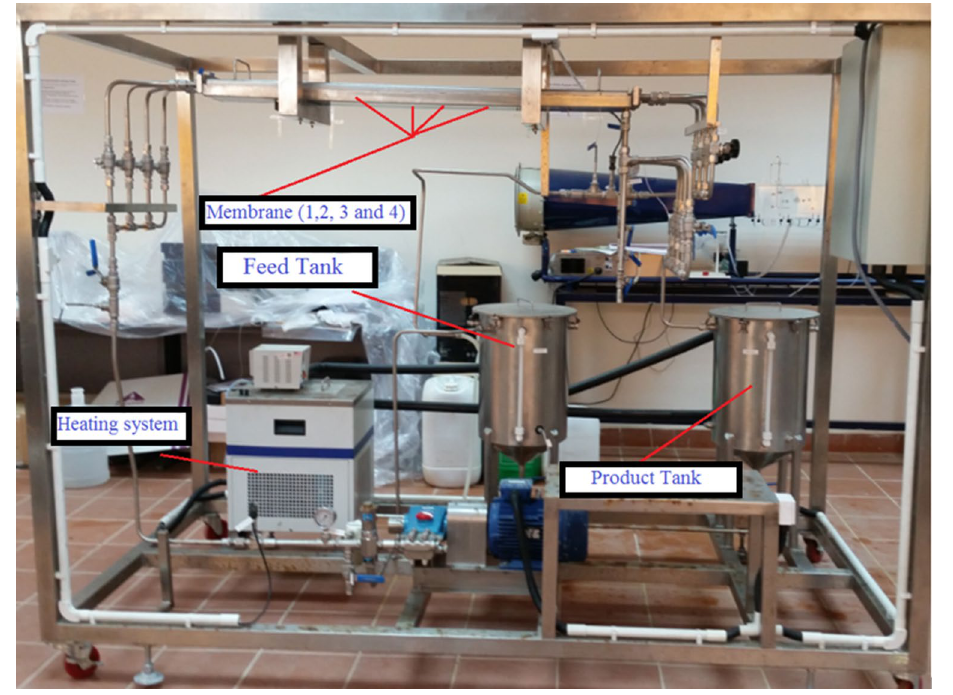
Fig. 4 The membrane filtration test unit; Model: TR 14 Table 9 Procedure and desired operating conditions for the four commercial membrane types (SOLTEQ Company: Solution Engineering 2008; ITT PCI Membranes Ltd 2011; Perry and Green 1999; McCabe et al. 1993; Geankoplis